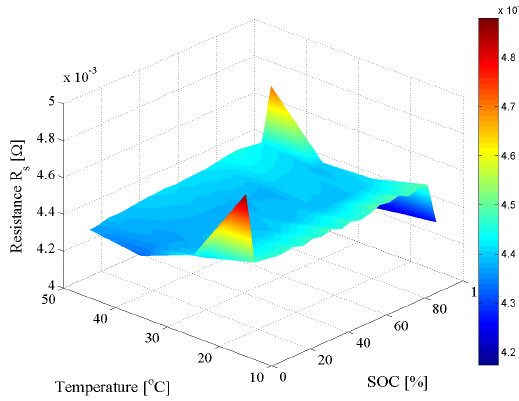
Figure 19. Two-dimensional look-up table implementation of R s of the EEC.